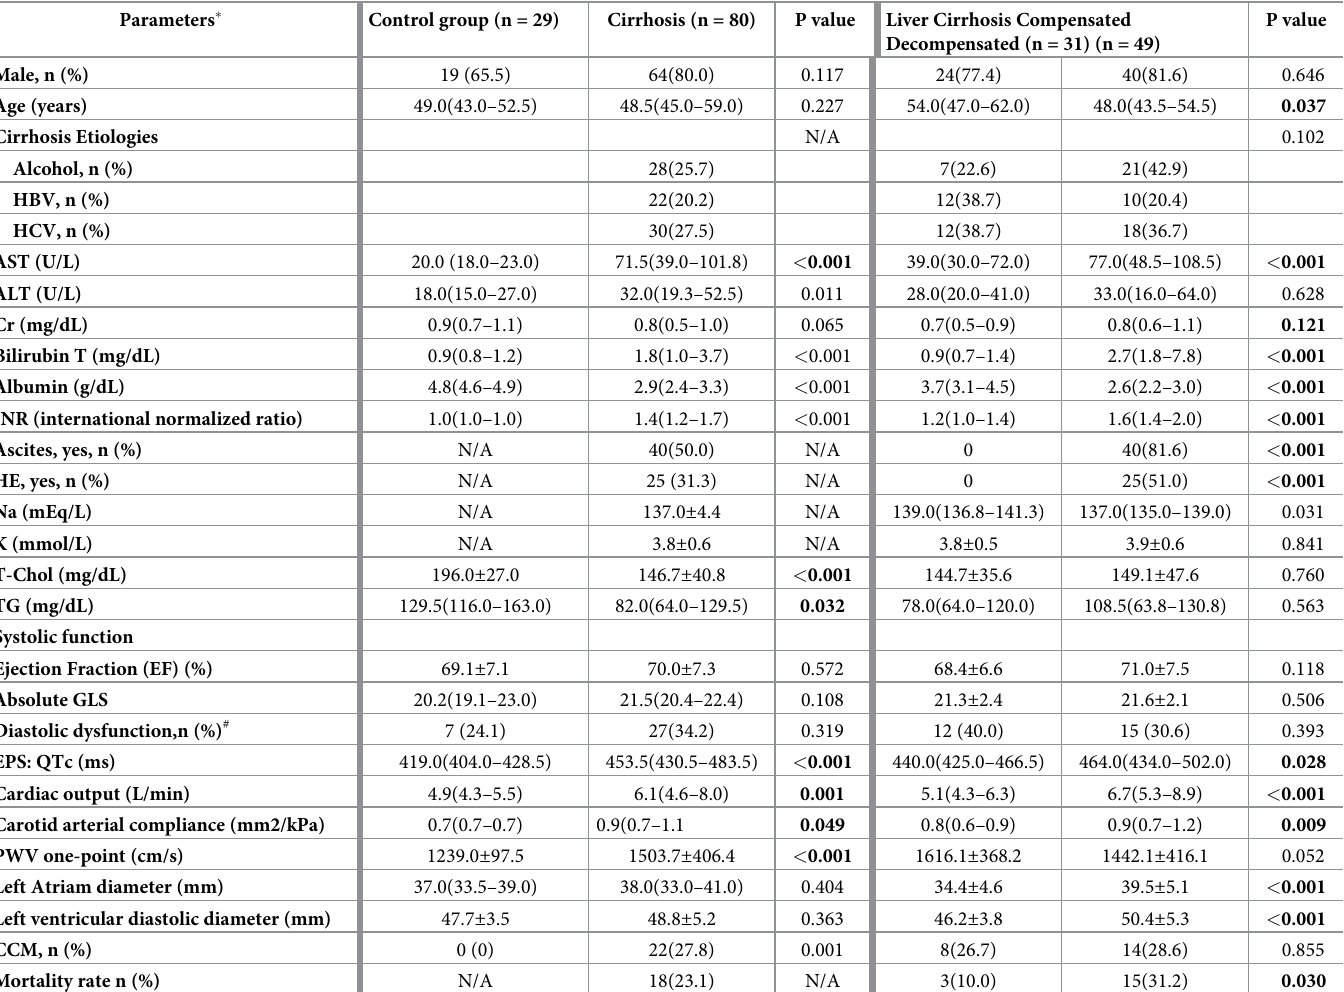
Table 1. Demographic characteristic of normal controls and patients with liver cirrhosis (compensated vs.